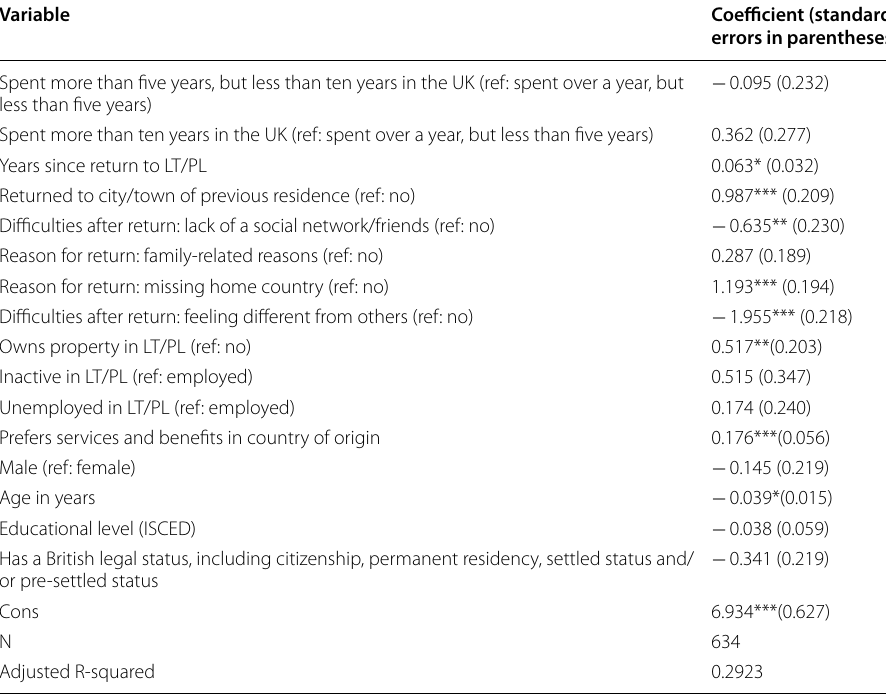
Table 2 Regression model: attachment to the place of